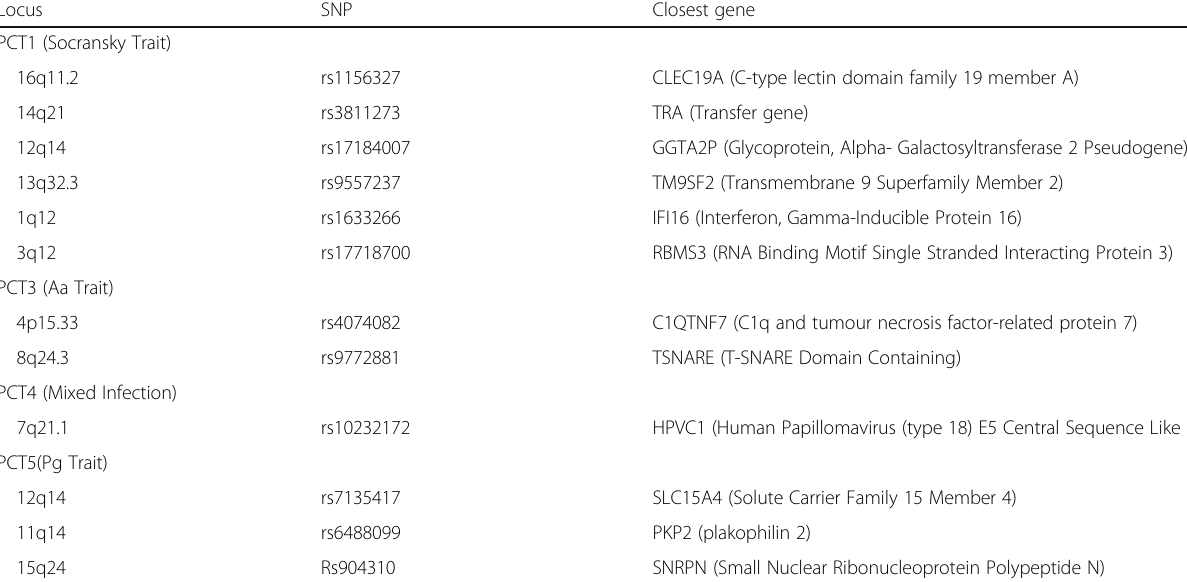
Table 1 Genome wide significant signals and the closest gene associated Locus SNP Closest